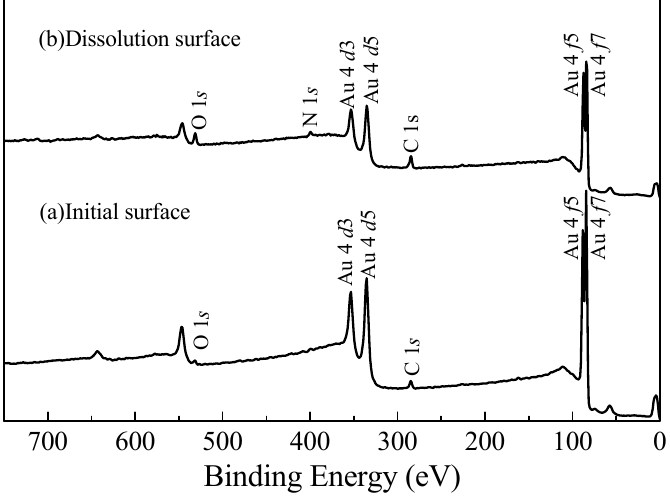
Figure 11. XPS wide energy spectrum of initial and dissolution surfaces. The narrow sweep curve of Au on the initial and dissolution reaction surfaces are shown in Figure 12a. The binding energies of the two main peaks are approximately 83.90 eV, which is consistent with the binding energies of the 4 f 7 peak from the Handbook of X-ray Photoelectron Spectroscopy [30]. The obtained results confirmed that there was a large amount of Au on the surface of the sensor. In addition, the characteristic peak of the dissolution surface shifted towards the high energy direction compared to the initial surface. This result indicates that the charge density around Au atoms decreased after the reaction, and positively charged Au emerged to the surface of the sensor.